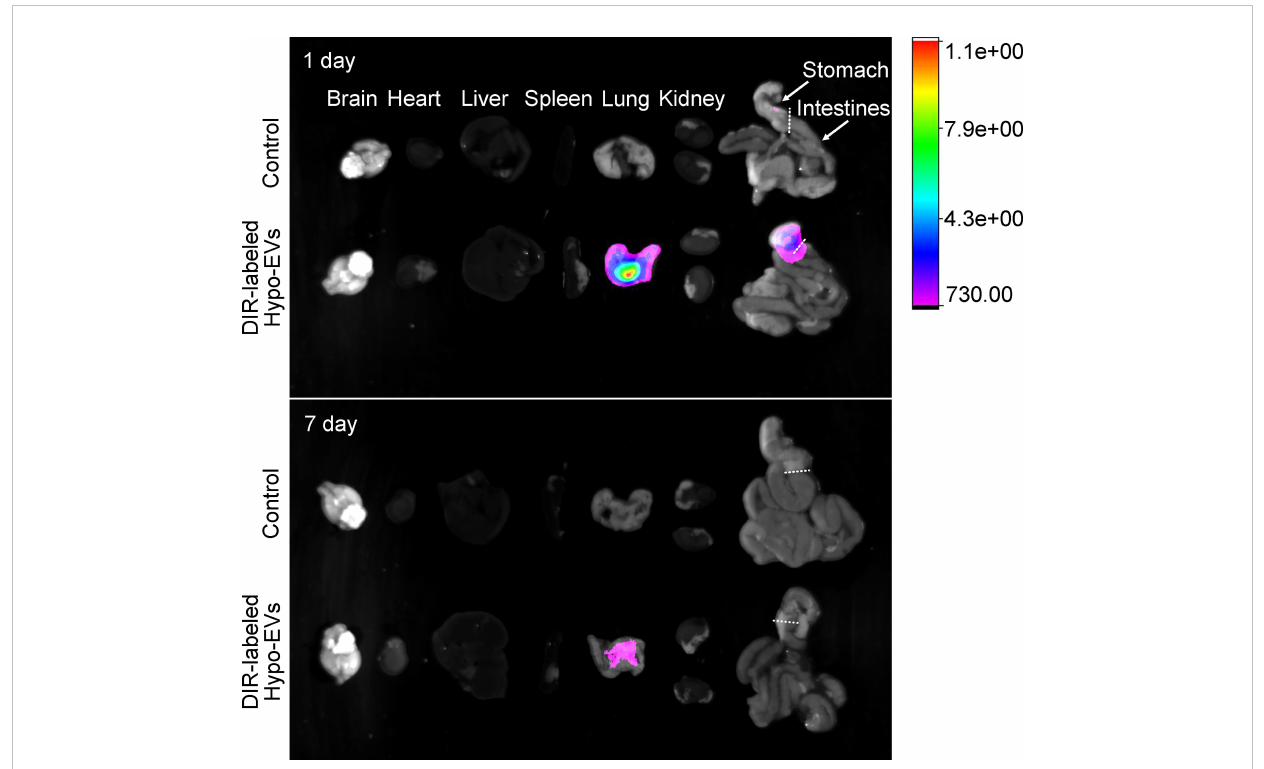
FIGURE 3 Biodistribution of Dir-labeled Hypo-EVs in major organs (brain, heart, liver, spleen, lung, kidney, stomach, and intestines) was visualized at 1 and 7 day after nebulized inhalation